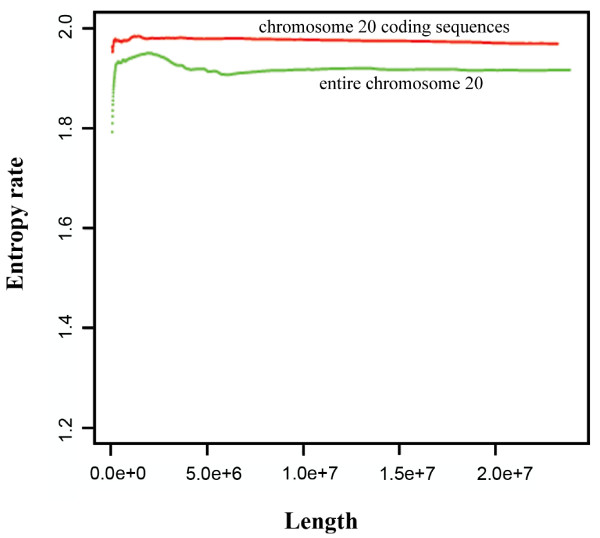
Entropy rate, using the Lempel-Ziv 77 algorithm, for the coding sequence (red) and the genomic sequence for chromosome 20 (green), as a function of the length of the sequence analyzed. The entropy calculation converges after 10 million bases.